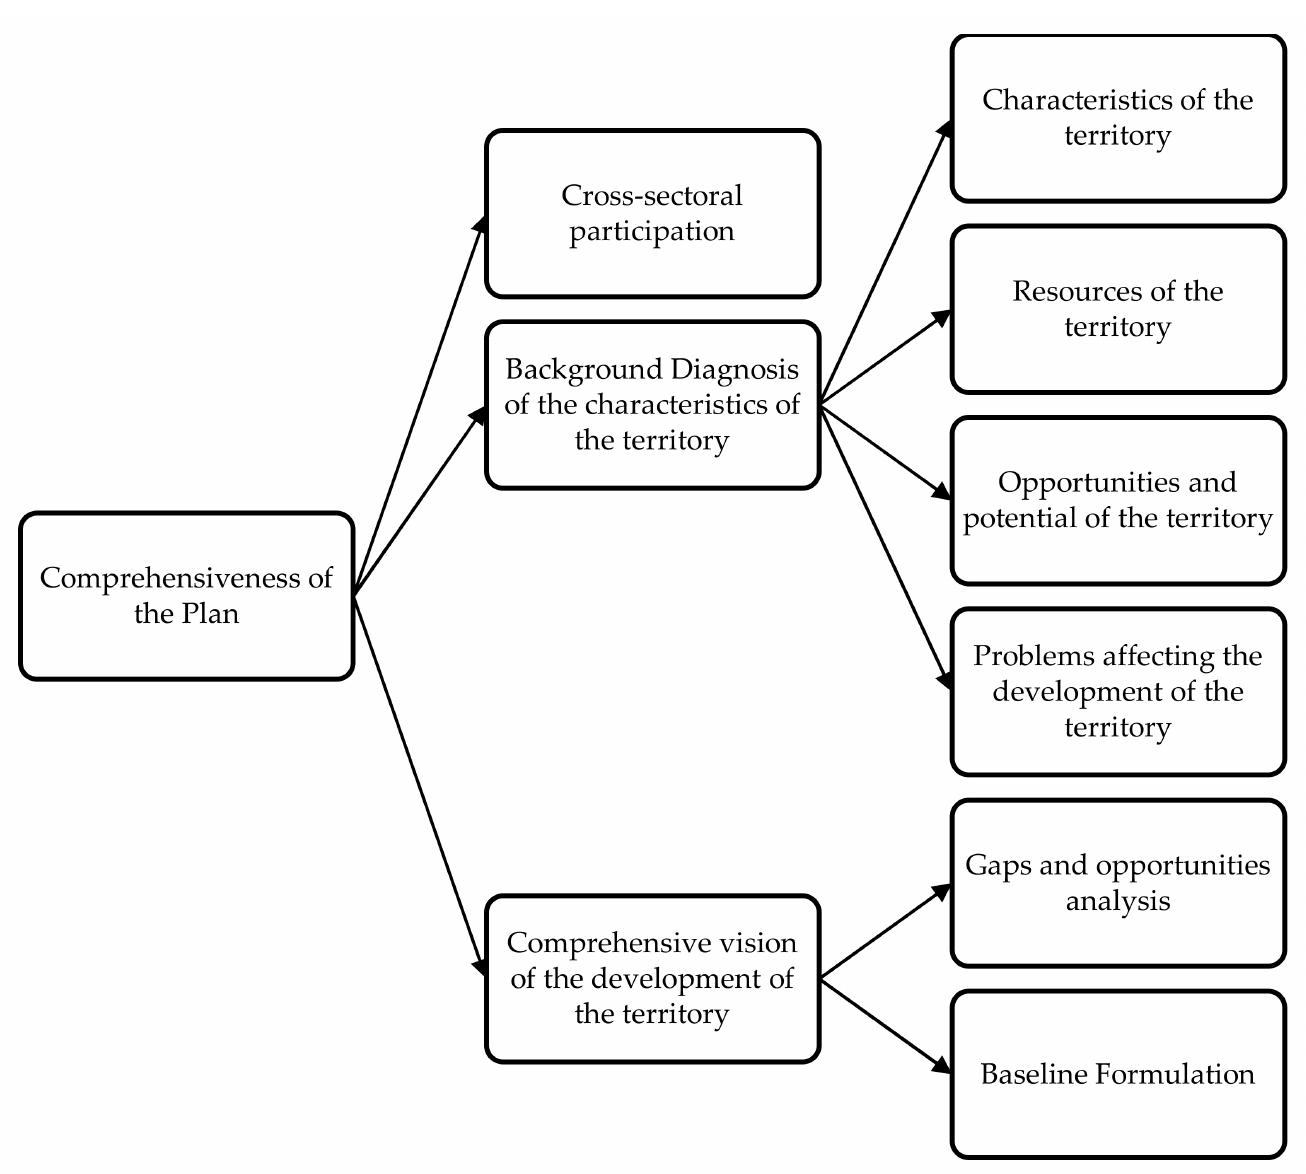
Figure 3. Sub-criteria for the Criterion “Comprehensiveness of the